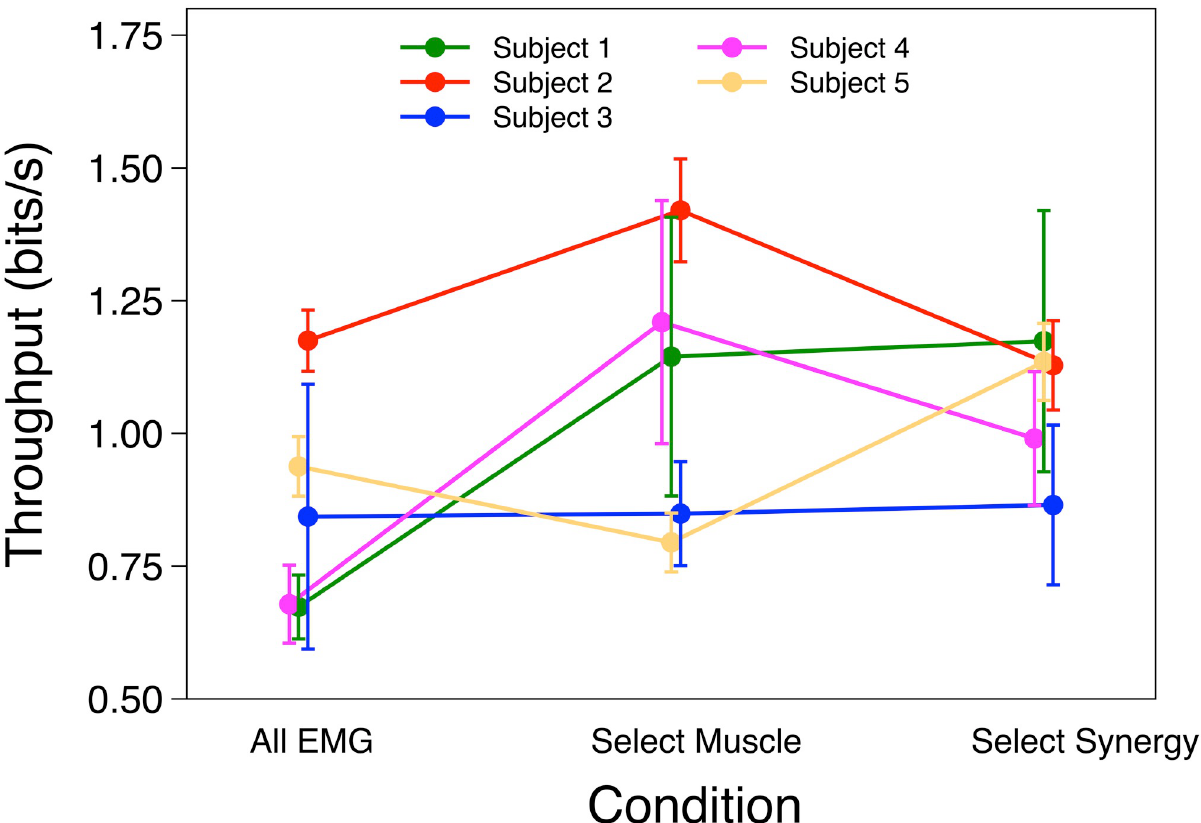
Fig 5. Throughput. Mean and SEM of Throughput (TP) of each participant using All EMG, Select Muscle and Select Synergy control.